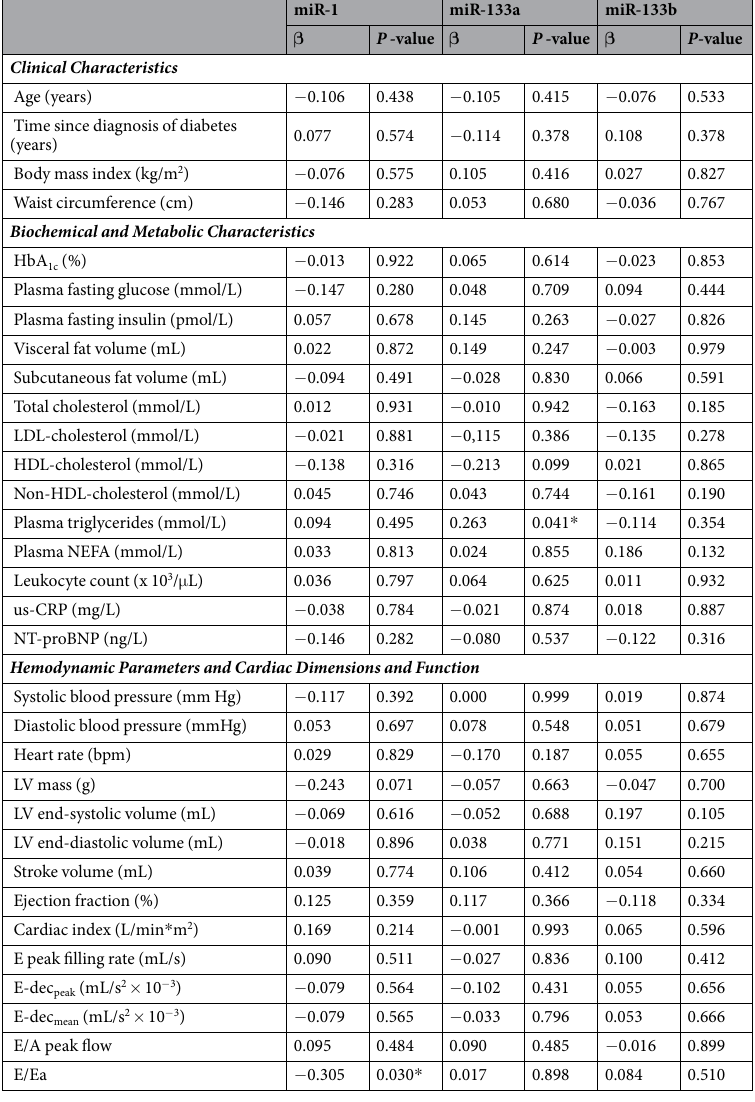
Table 2. Associations between serum cardiac-enriched miRNAs and characteristics of study population. Data are expressed as standardized beta ( β